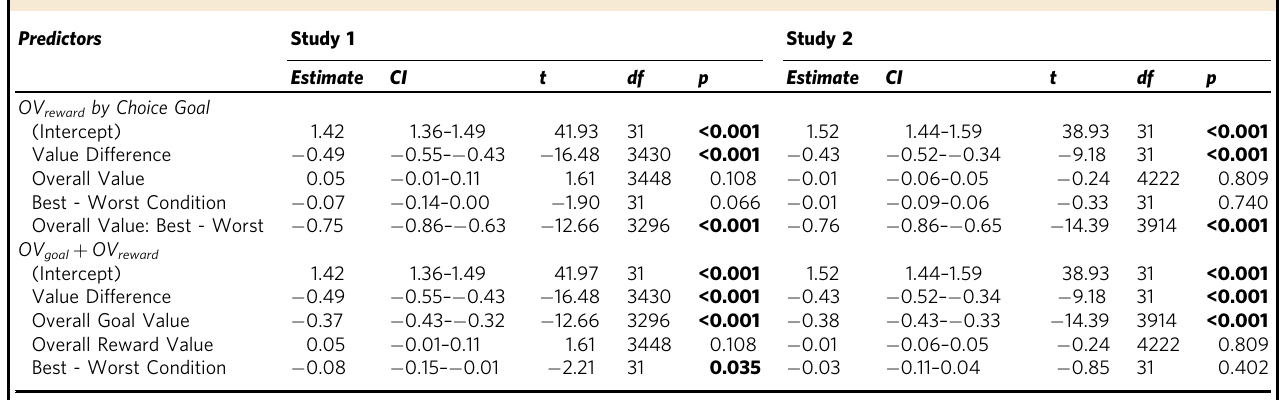
Table 1 Comparison of overall reward vs overall goal value effects on log RT Predictors